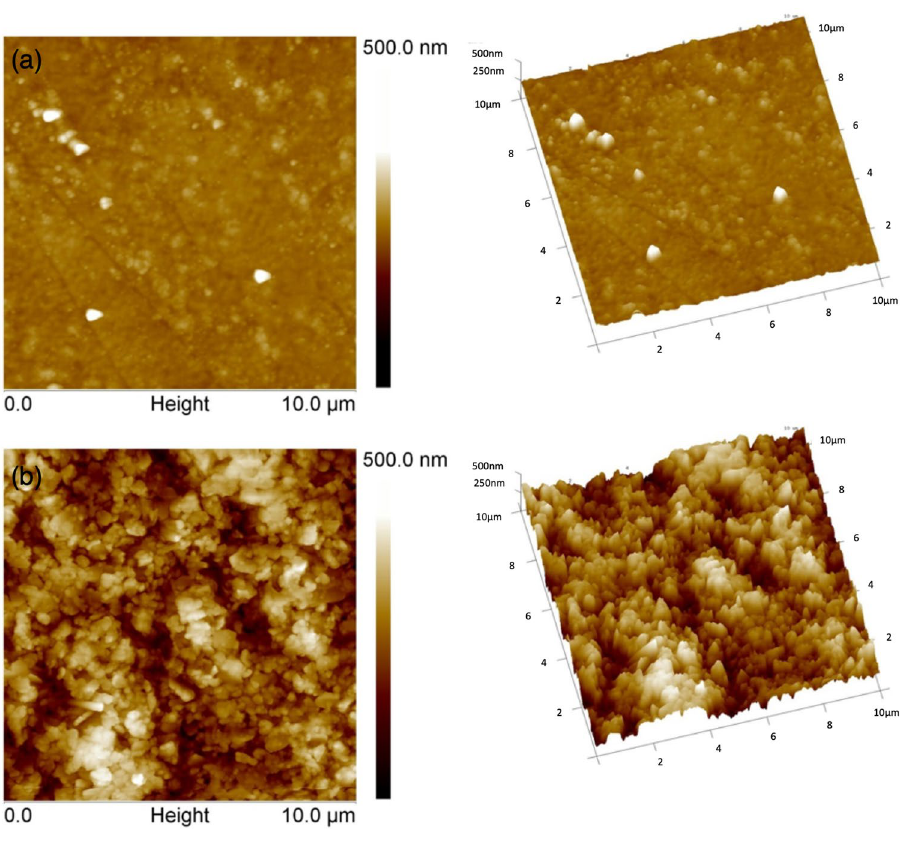
Figure 8. AFM images in tapping mode: ( a ) PET and ( b ) SBS. Height images of 10 µm × 10 µm scan area. 2D (left) and 3D (right) views. Z-scale for the height images is 500 nm. Tilt = 30° and rotation = 15°.